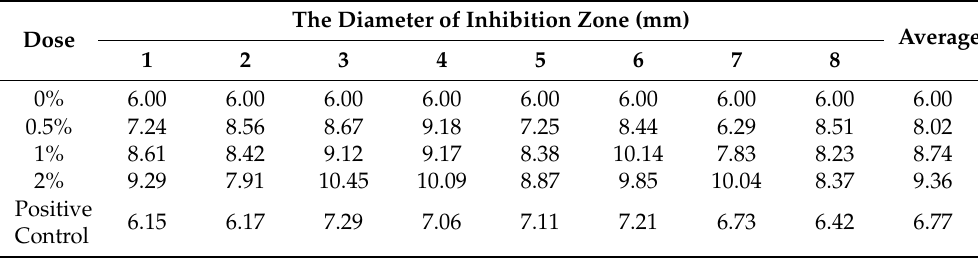
Table 4. Comparison of antibacterial activity of silver nanoparticles coated with chitosan against S. aureus bacterial strain for previous and current studies.